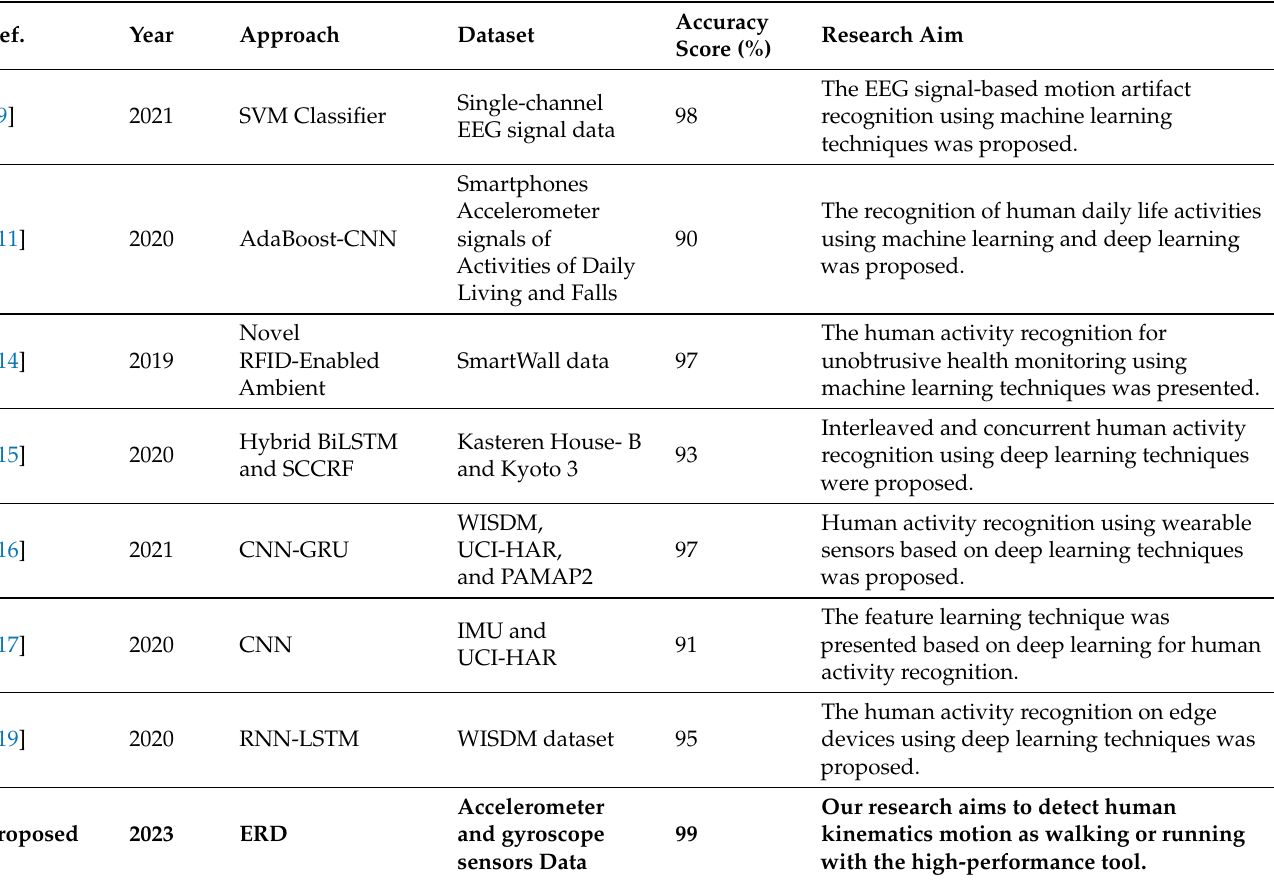
Table 1. Comparative analysis and related literature summary for human motion detection.